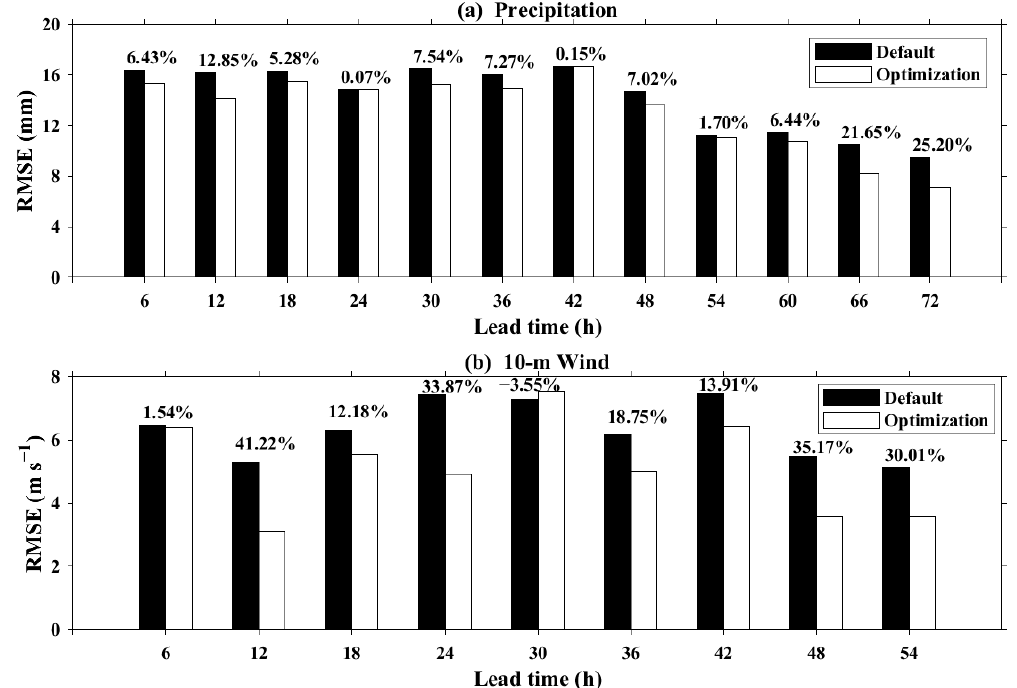
Figure 6. Comparisons of the simulation errors using the WRF model with default and optimal parameters at 6-hourly lead times for: ( a ) precipitation ( b ) 10-m wind.